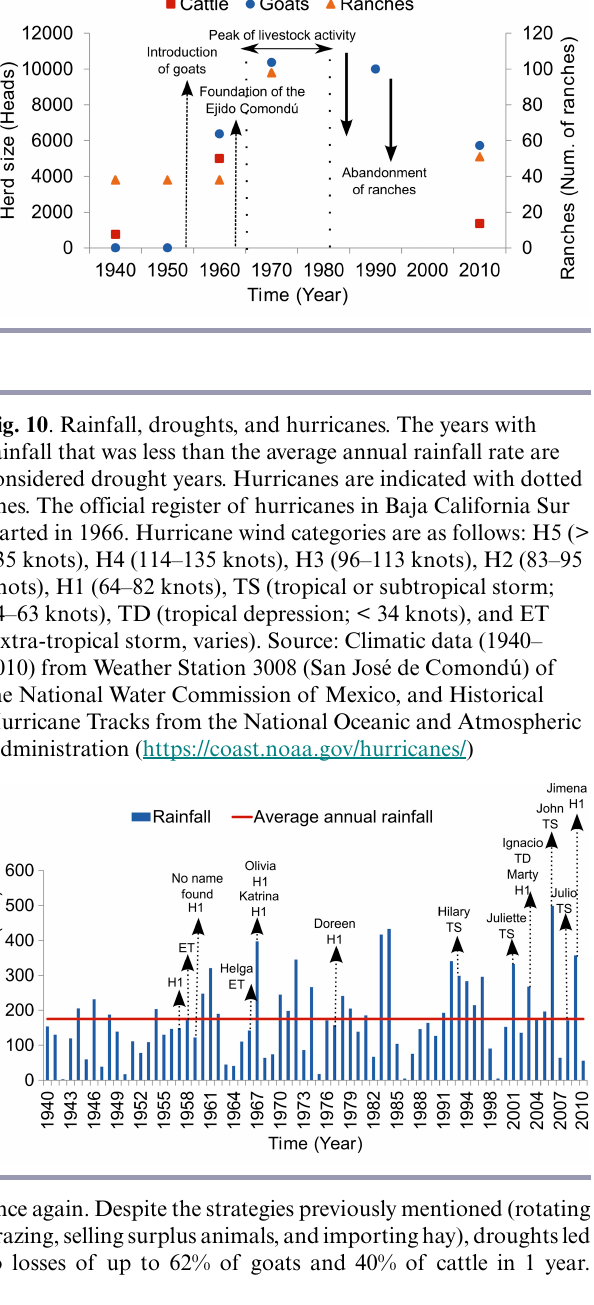
Fig. 9 . Livestock activity in the oasis of Comondú. Orange triangles denote occupied ranches, red squares are cattle, and blue points are goats. Dashed arrows indicate the introduction of goats and the creation of the Ejido Comondú; dotted lines indicate the period with the largest number of occupied ranches and heads of cattle and goats (1970–1980). The periods when ranches were abandoned are indicated with black arrows. Source: The 1962 General and Agricultural Census of the Official Gazette of the Government of the Territory of Baja California Sur (1968), and in-depth interviews.